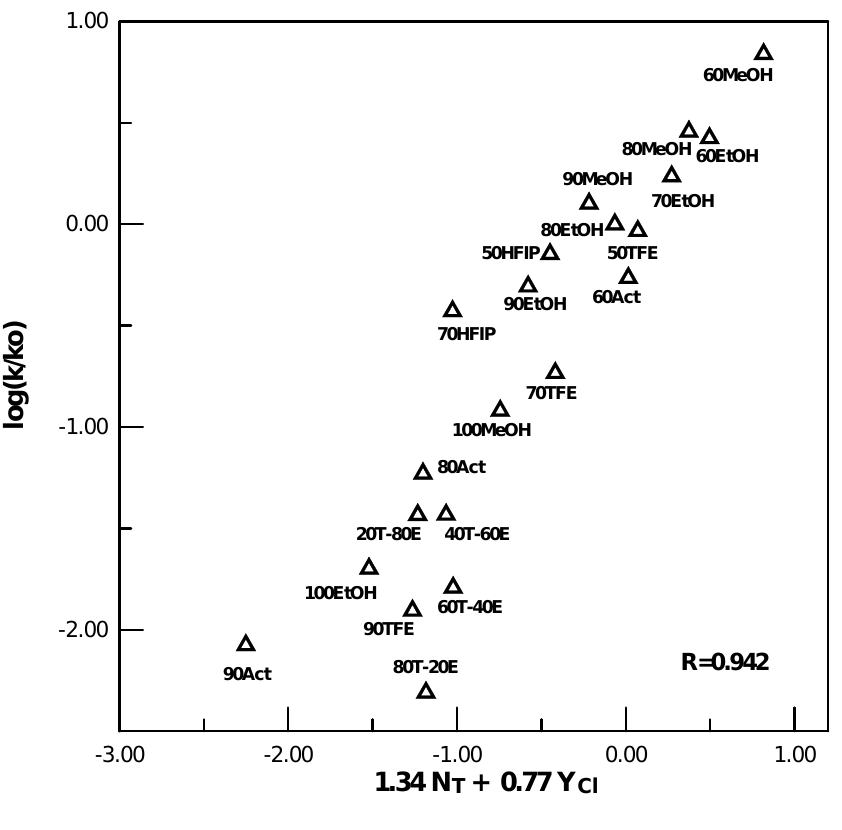
Figure 1 . Plot of log (k/k ) for solvolyses of ethyl fluoroformate at 24.2°C against (1.34 N o ). The data points for TFE-ethanol mixtures are not included in the + 0.77 Y Cl